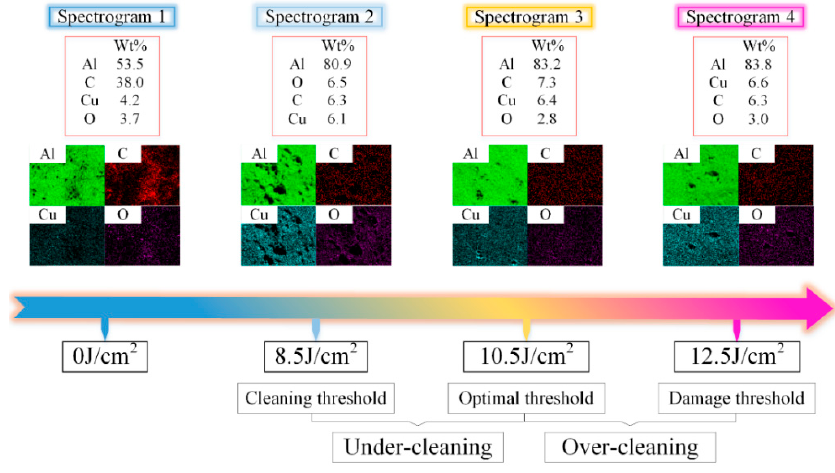
Figure 4. Flow chart of the cleaning process.